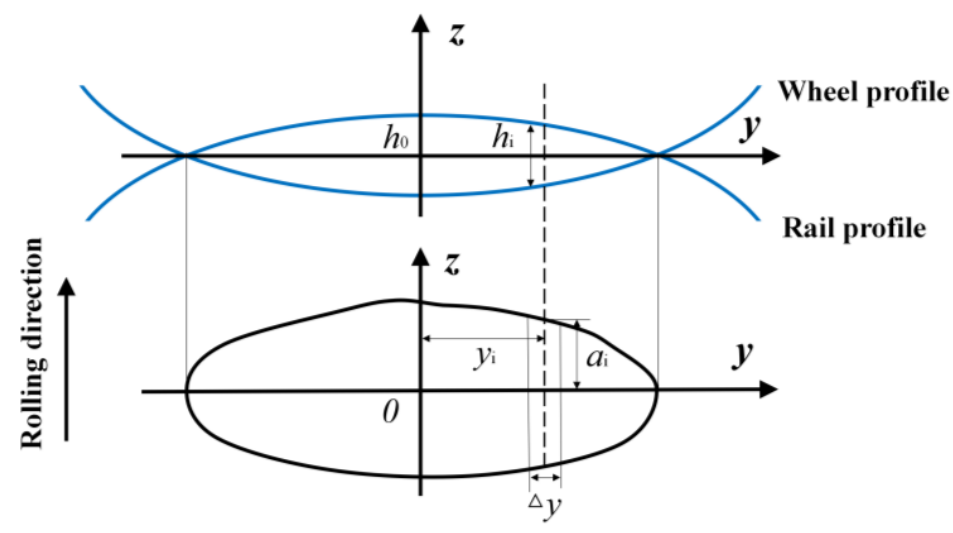
Figure 5. The semi-Hertzian method.